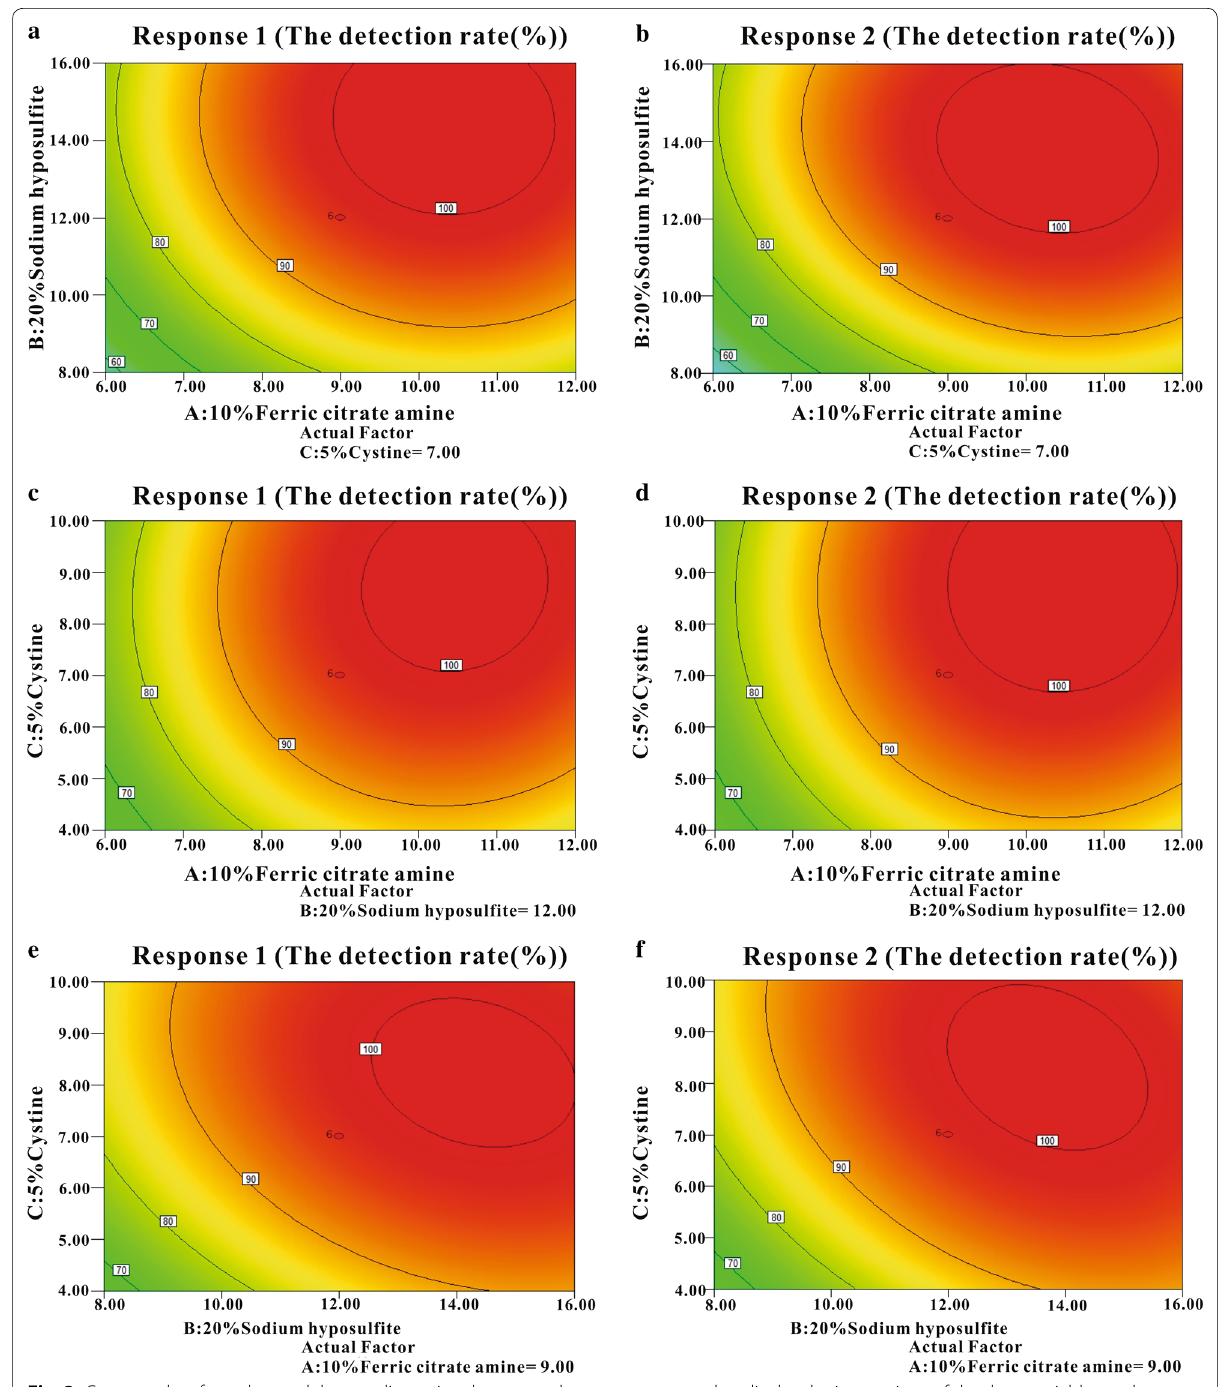
Fig. 3 Contour plots from the models: two-dimensional contour plots were generated to display the interactions of the three variables to the response. These contour plots were generated by keeping one variable at a constant position and assessing the action of the other two variables. In the models, 5% cystine ( a , b ), 20% sodium hyposulfite ( c , d ) and 10% ferric citrate amine ( e , f ) were kept at a fixed level in